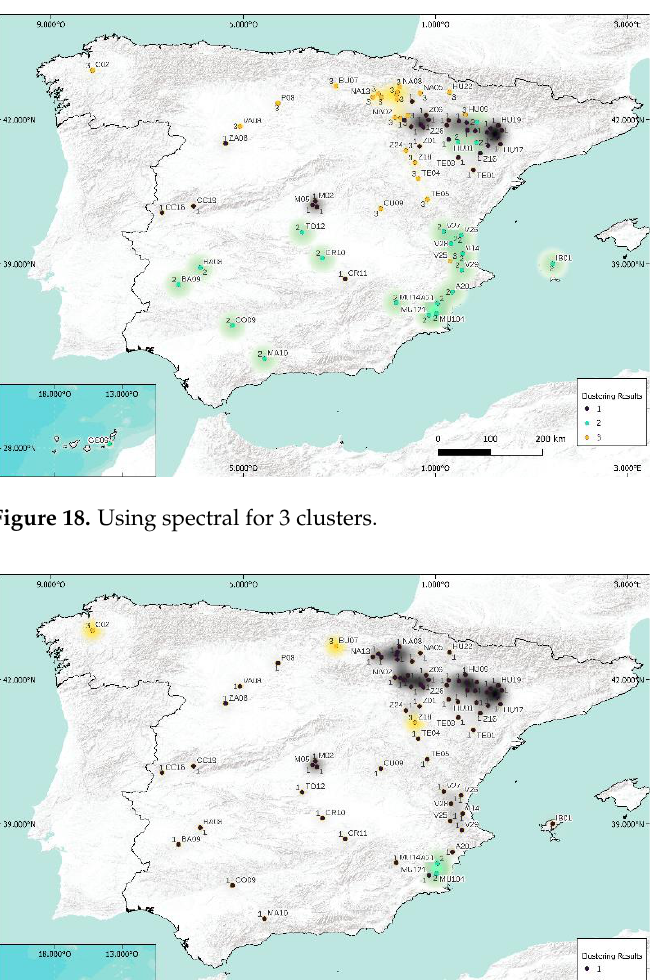
Figure 17. Using k-medoids for 3 clusters.